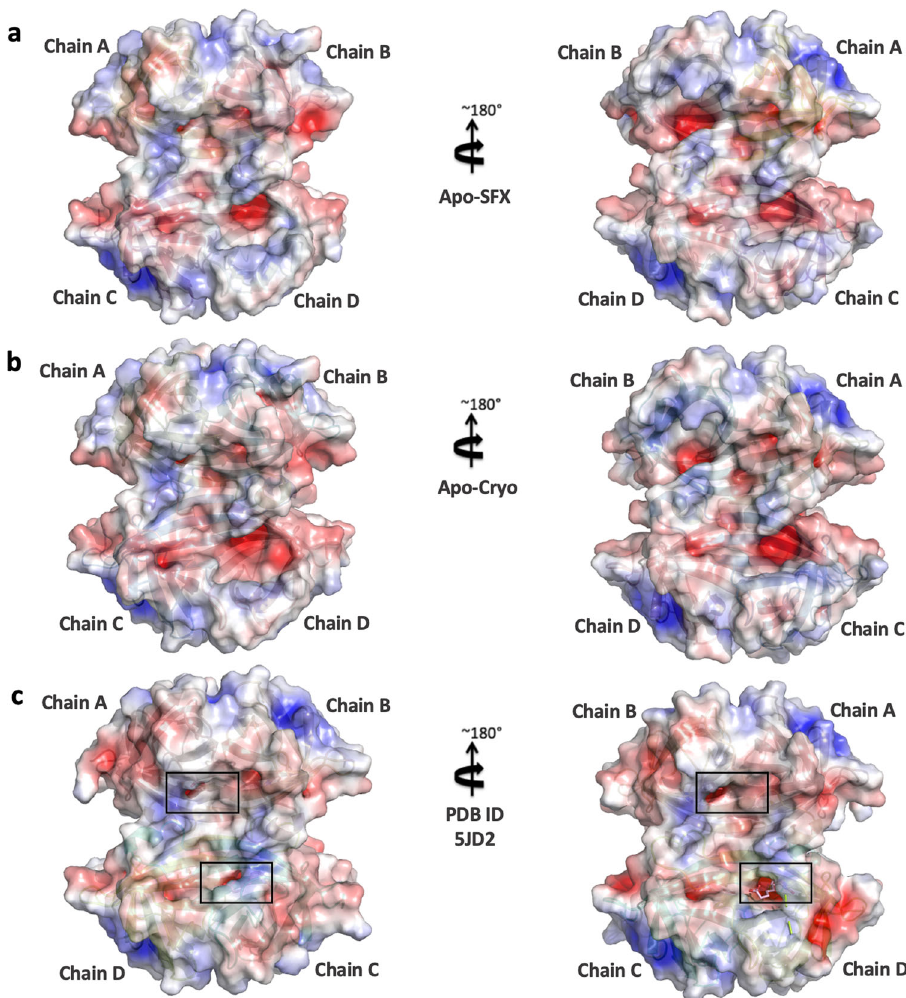
Fig. 7 Representation of electrostatic surfaces. a Apo-SFX structure of streptavidin, b Apo-Cryo structure of streptavidin, and c Holo-SFX streptavidin in complex with selenobiotin (PDB ID: 5JD2) are shown to detect the charge distribution. Holo-SFX structure is colored in light pink and shown with